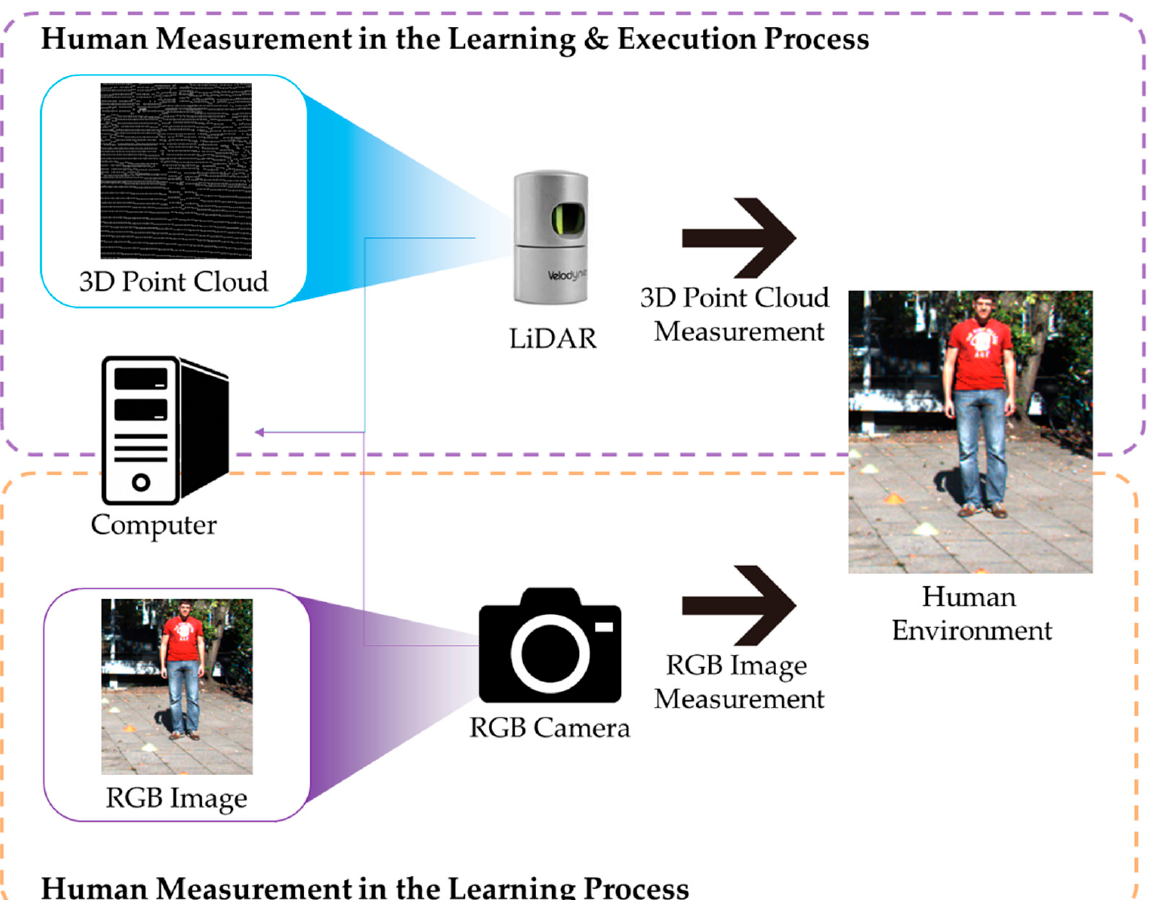
Figure 2. A device that measures the human in the learning and execution processes.